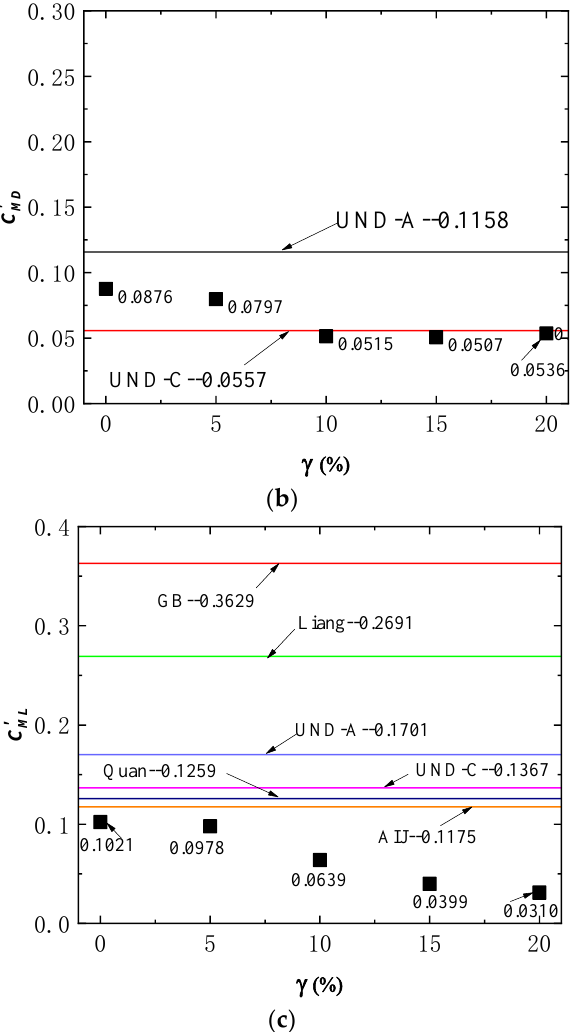
Figure 11. The base moment coefficients at different corner set − back rates.